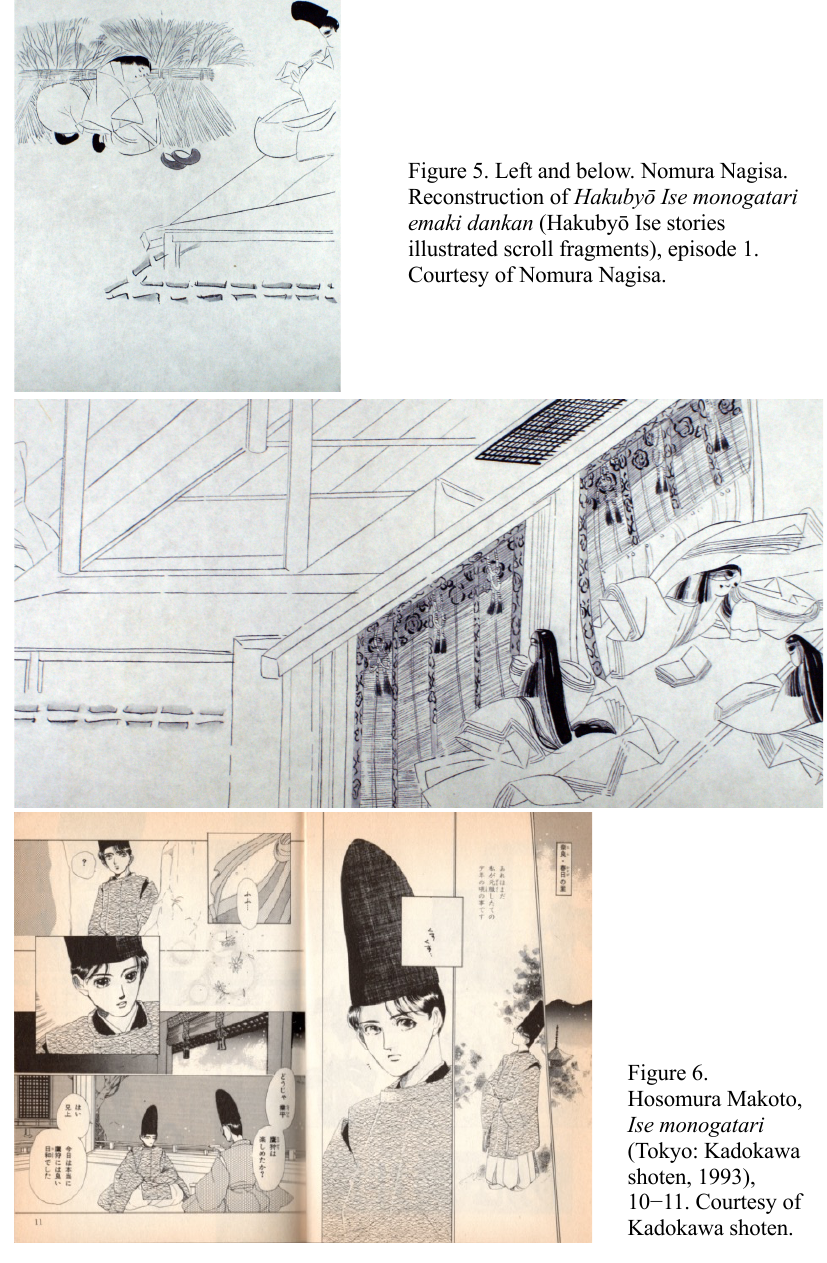
Figure 6. Hosomura Makoto, Ise monogatari (Tokyo: Kadokawa shoten, 1993), 10−11. Courtesy of Kadokawa